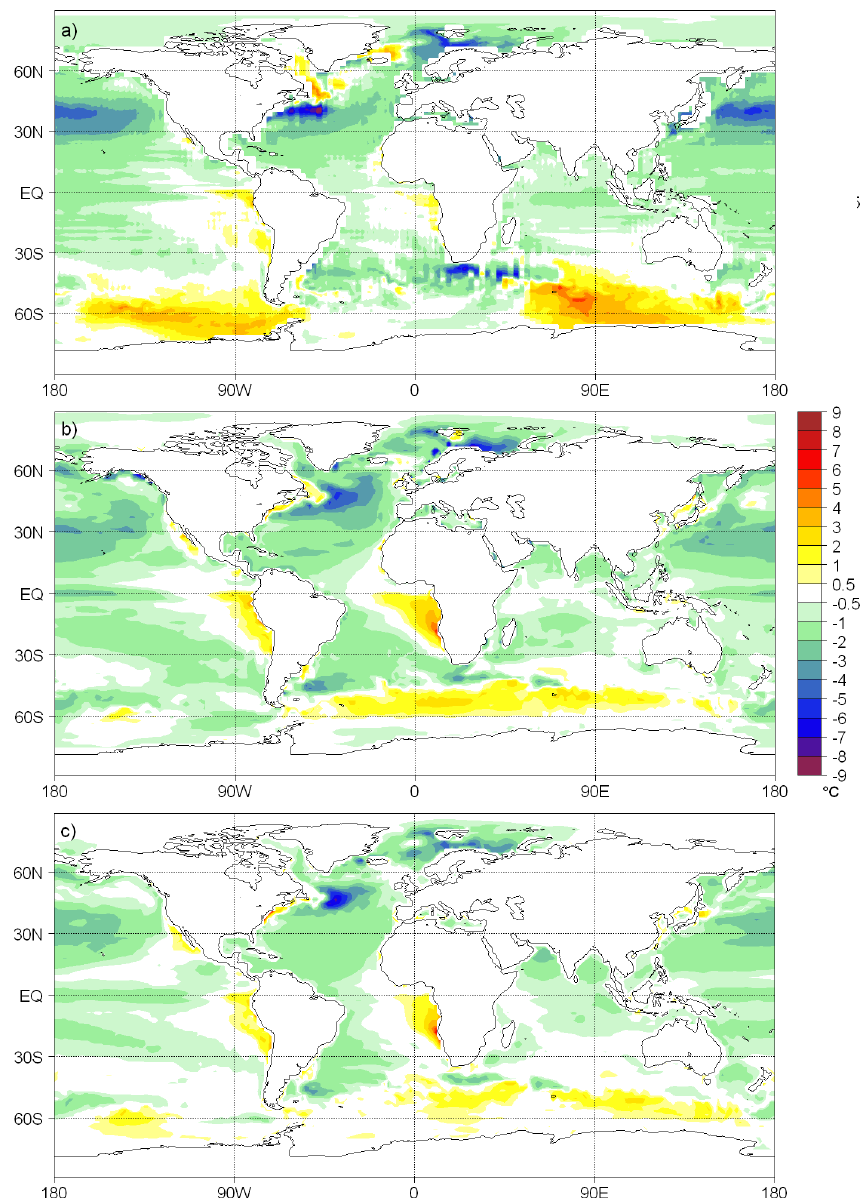
Fig. 15. Simulated annual mean SST anomalies for the preindustrial climate relative to SSTs in the ocean reanalysis data SODA (Carton and Giese, 2008; Carton et al., 2005). Calculated for ECHO-G (a) , from the ensemble median mean of the models listed in PMIP2 (b) and PMIP3 (c)